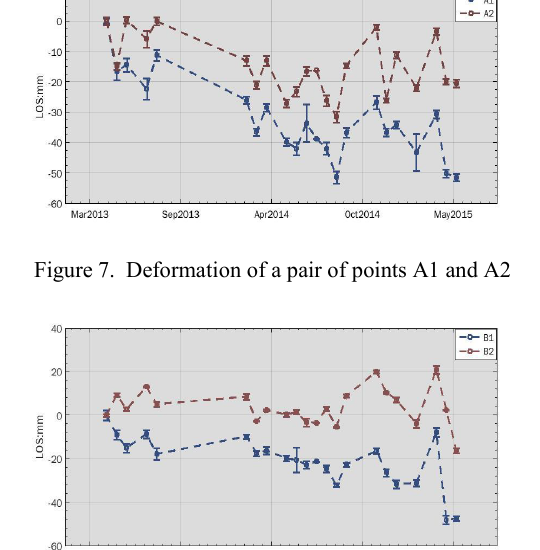
Figure 8. Deformation of a pair of points B1 and B2